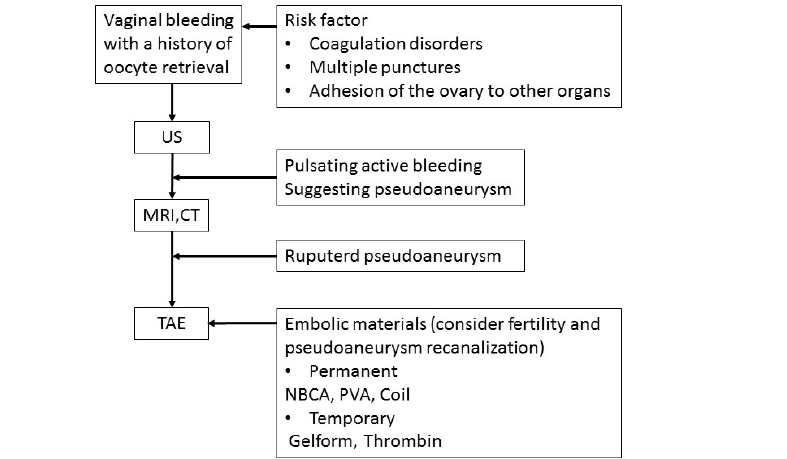
Figure 3. Management algorithm for patients with vaginal bleeding with a history of oocyte